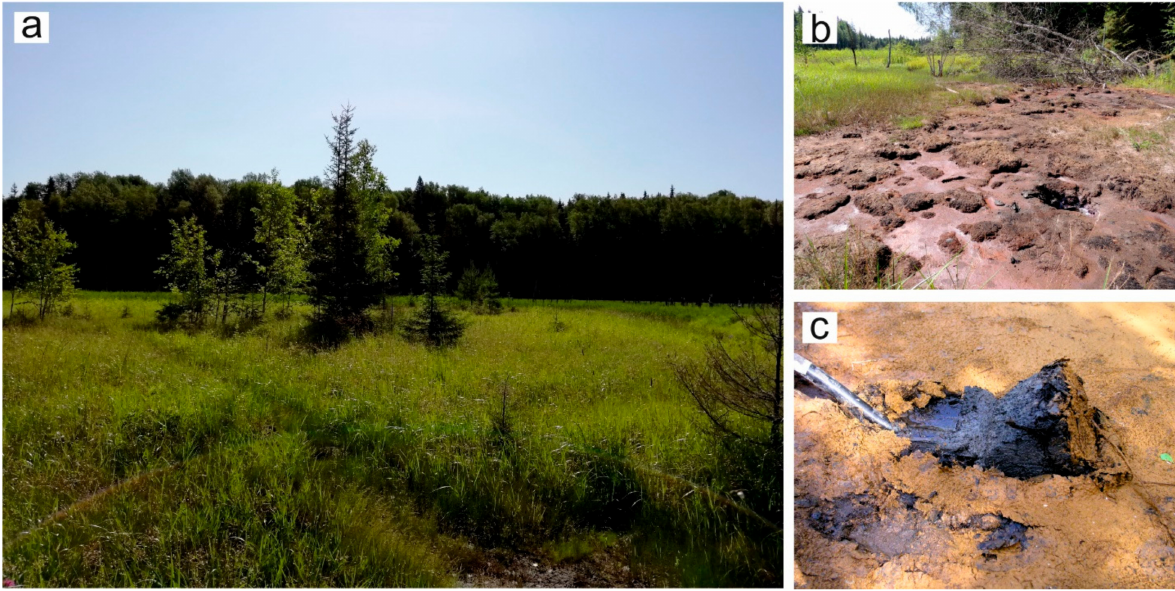
Figure 5. Soil sampling sites: ( a ) Gleyic Fluvisols (Salic, Loamic); ( b ) Chloridic Gleyic Fluvic Solonchak (Hypersalic, Loamic); ( c ) iron–bearing crust on the surface of the soil and black gel–like phases in lower sulphide horizon of Chloridic Gleyic Fluvic Solonchak (Hypersalic,